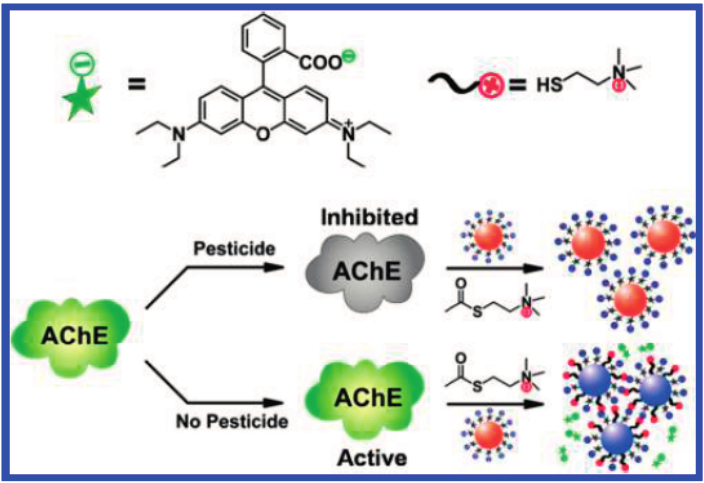
Figure 3. Design of the dual-readout (colorimetric and fluorometric) assay for pesticides. Reprinted with permission from [37]. Copyright 2012 American Chemical